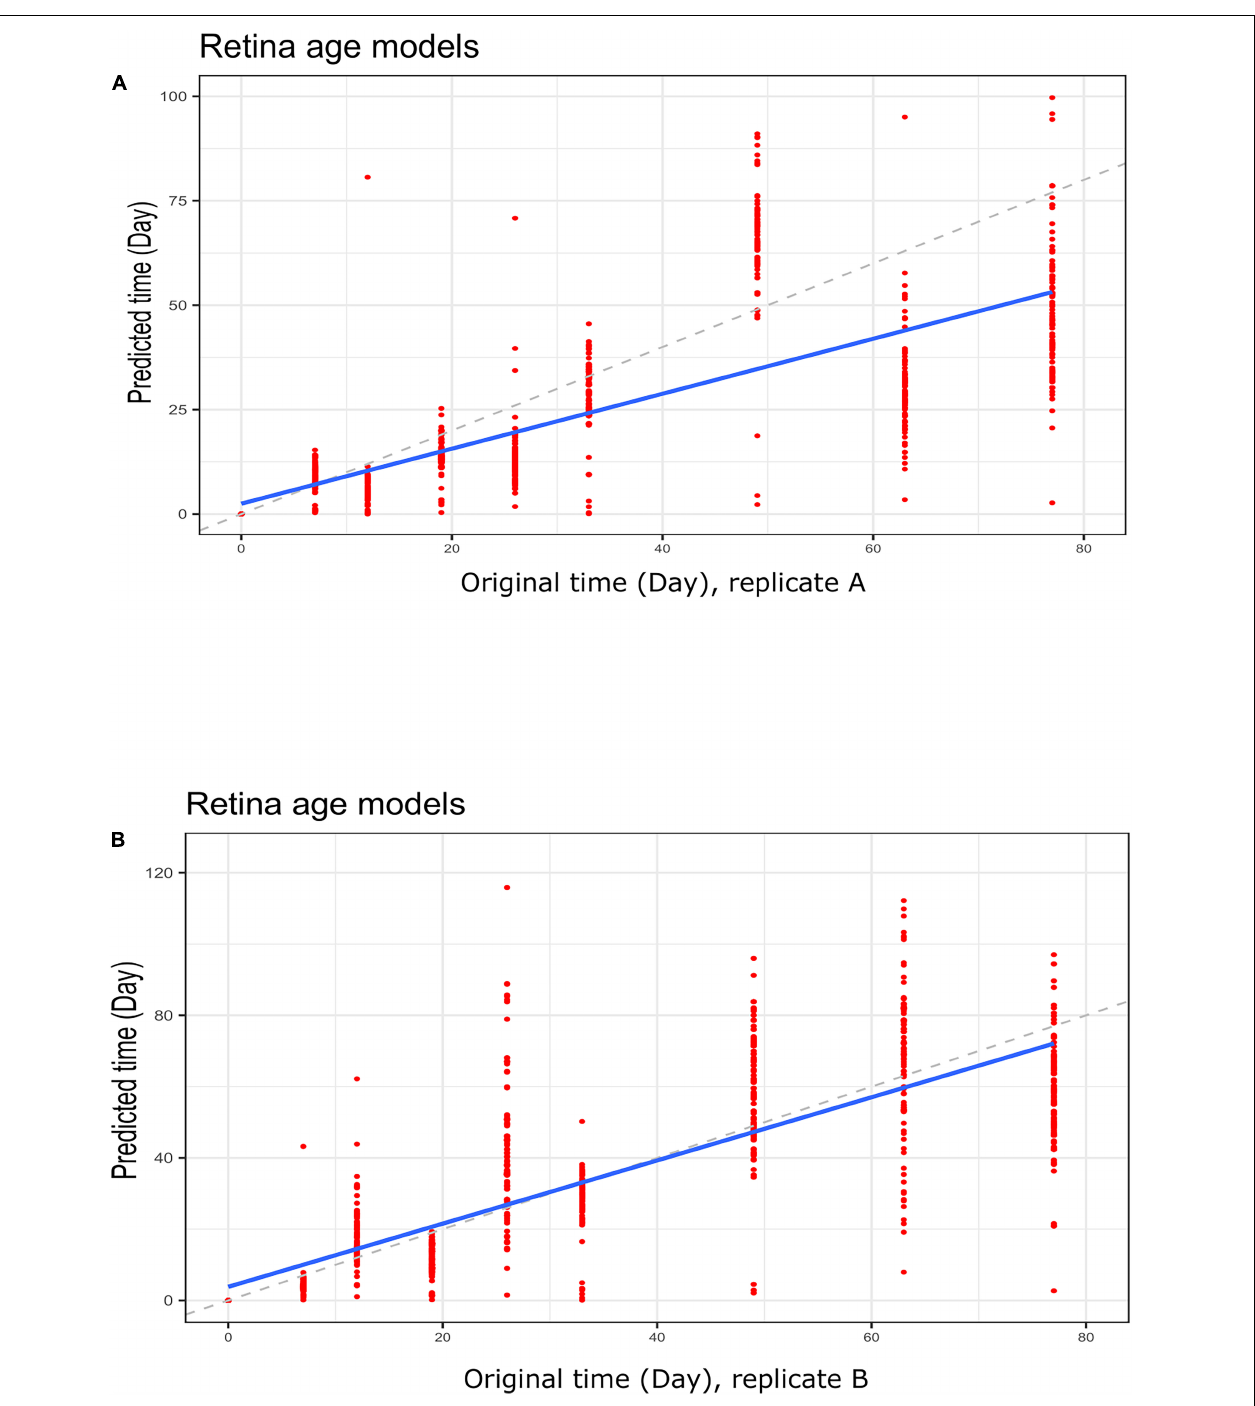
FIGURE 6 | Regression plots showing predicted time (clock age in days) and original differentiation time during neuronal differentiation. Data for (A) group A replicates and (B) group B replicates. Shown are data for retina (AMD MGS1) age models using a LOOCV approach to re-adjust model coefficients. Note a much closer correspondence between differentiation age (in days) and clock age estimates (in